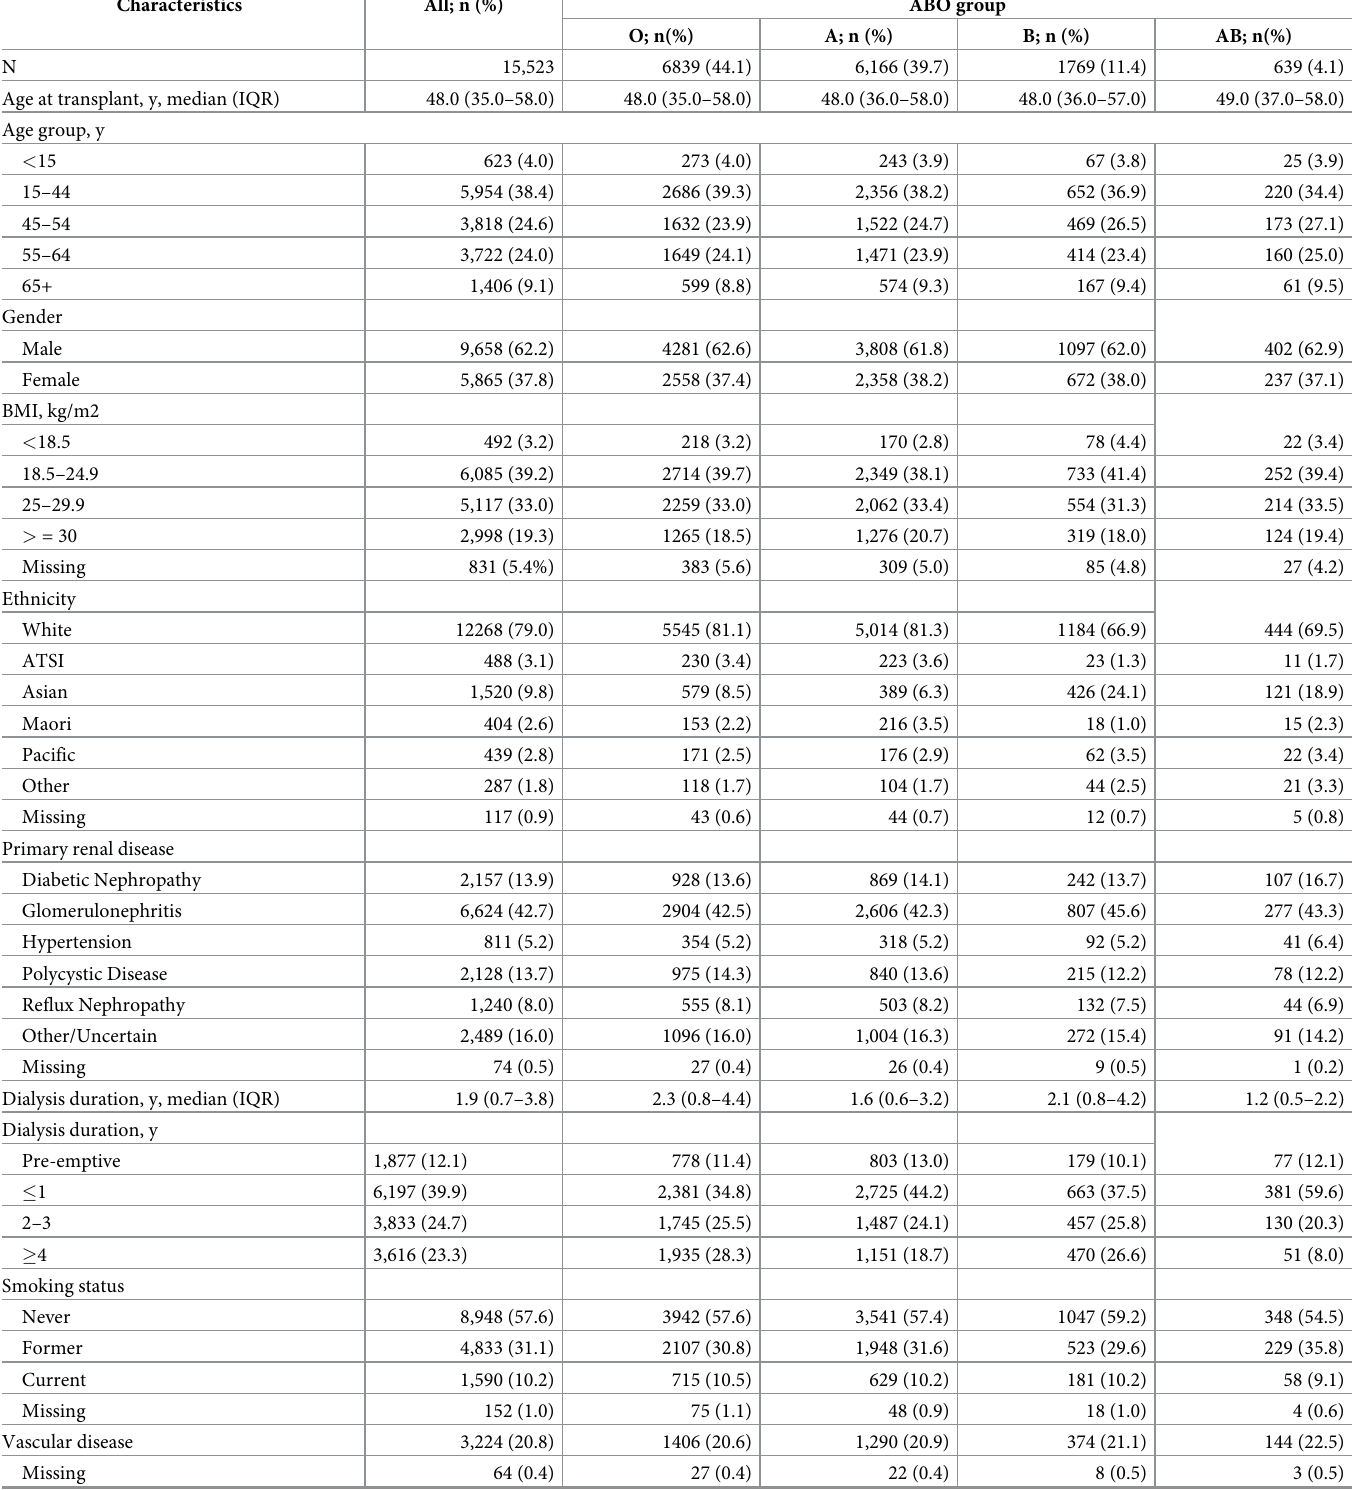
Table 1. Patient characteristics at transplant between ABO groups (n = 15,523).